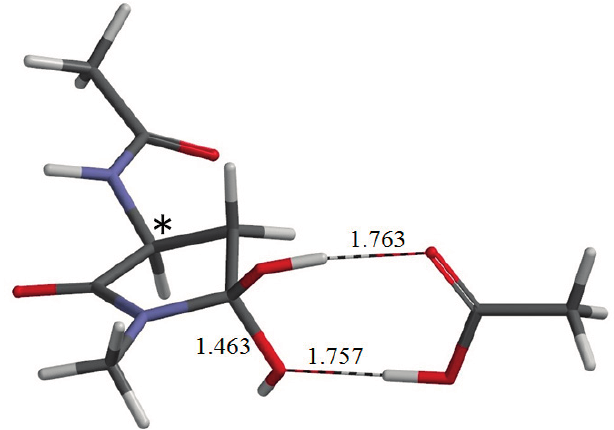
Figure 7. The geometry of I•AA-2 ( φ = − 170°, ψ = − 145°, χ 1 = 146°), which is the intermediate complex directly connected to TS-2. Selected interatomic distances are shown in Å. The asterisk (*) indicates the α